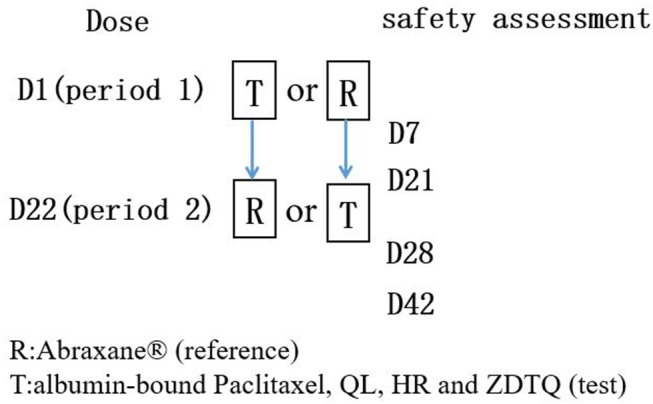
Flow chart of the BE studies. Each subject will had test product (QL, HR, or ZDTQ) and reference product (Abraxane®) at each study.